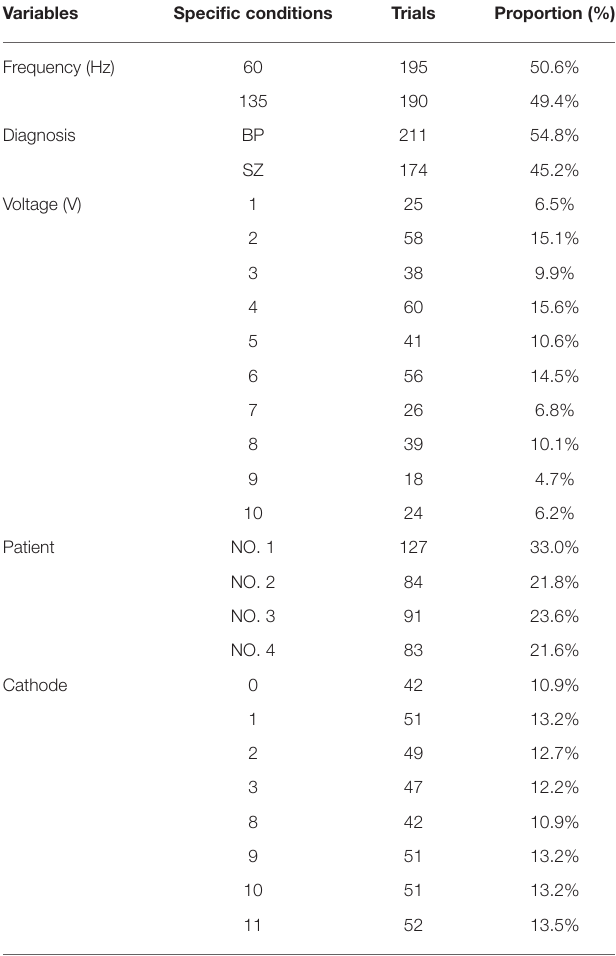
TABLE 1 | Conditions of the different